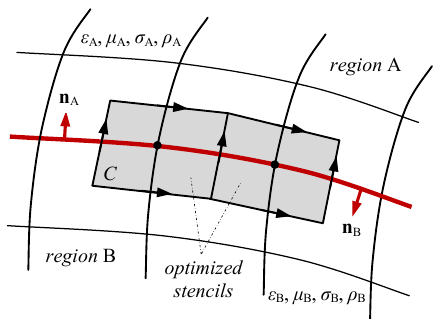
Figure 2: Integration process for an electric field component at the interface of two dissimilar lossy materials by means of the complex-interface modeling method (grey